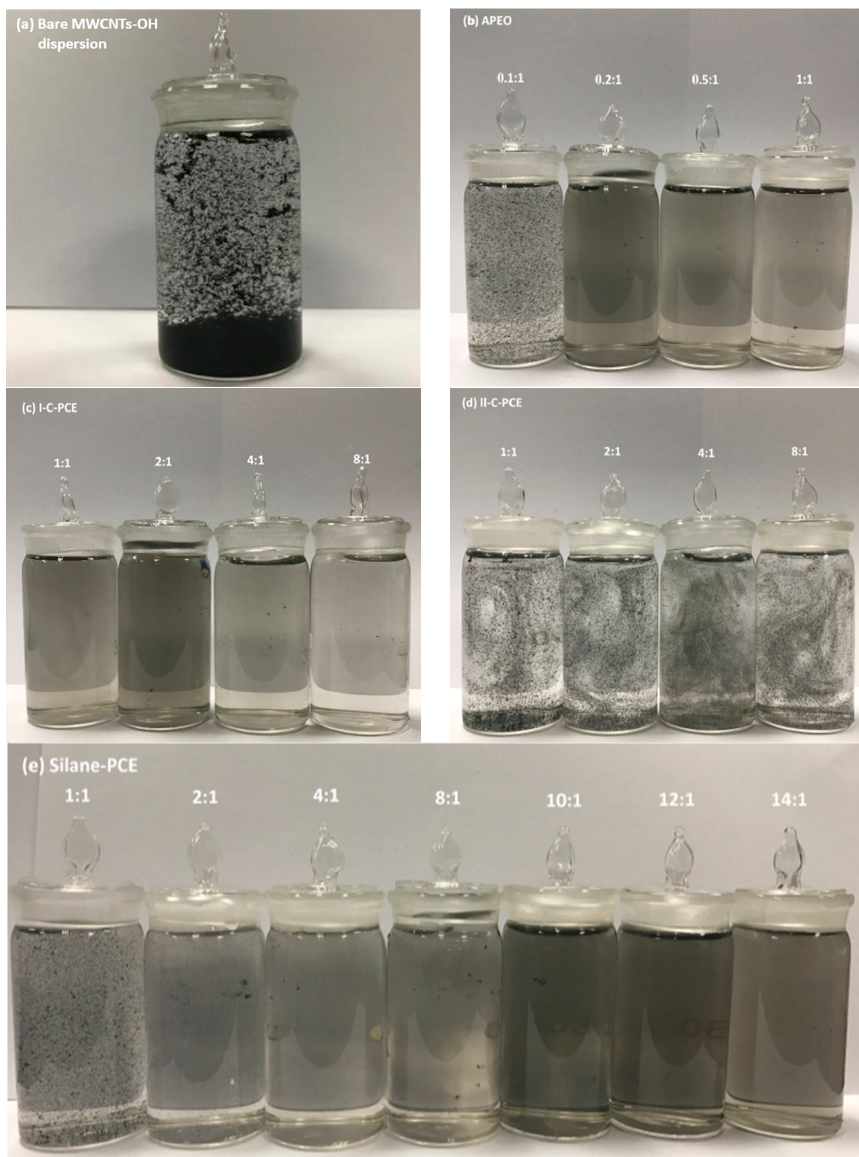
Figure 5. Photographs of MWCNTs–OH suspensions with different surfactants and ratios of surfactant/MWCNTs–OH: ( a ) bare MWCNTs–OH suspension; ( b ) APEO; ( c ) I-C-PCE; ( d ) II-C-PCE; ( e ) Silane-PCE.